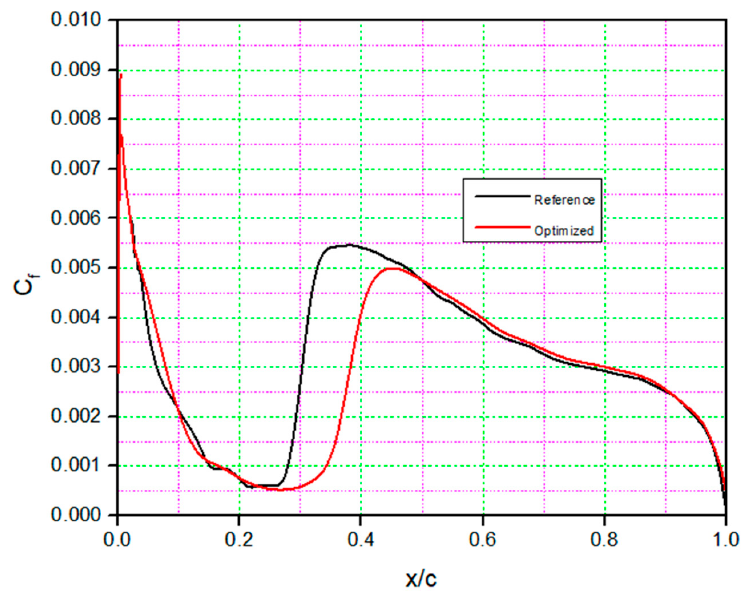
Figure 17. Assessment of the skin friction coefficient for the S45 optimized airfoil and for the reference airfoil for drag minimization.